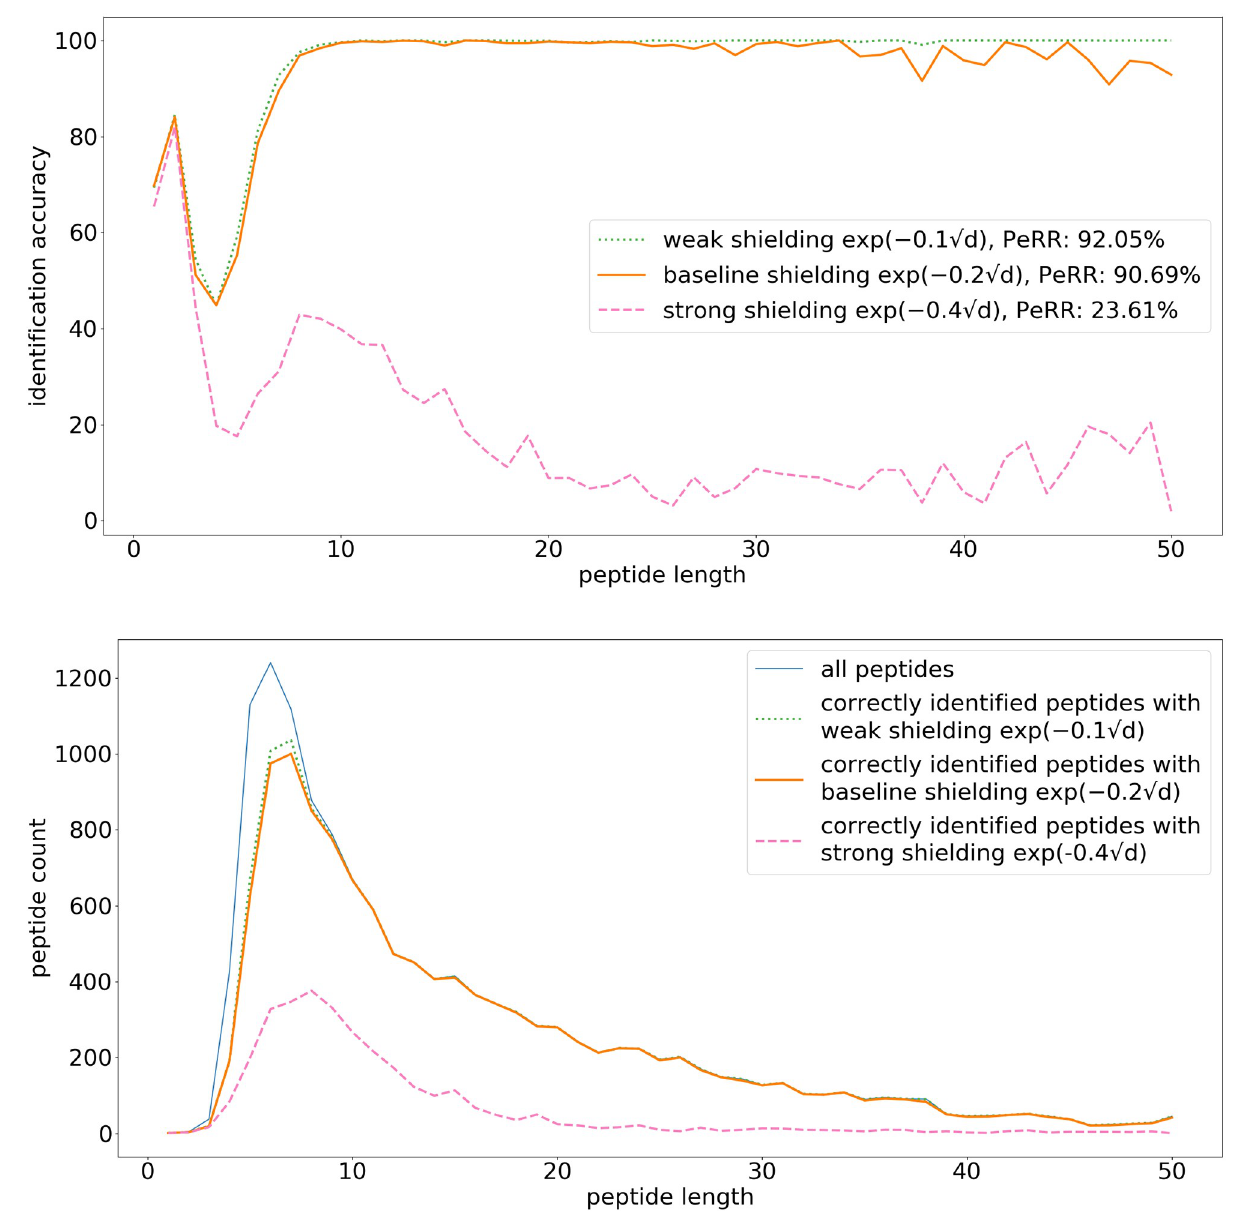
Fig 9. Peptide identification fraction: Shielding factor. (top) The fraction of correctly identified peptides for each peptide length. The legend additionally contains the peptidome recovery rate (PeRR). (bottom) The total peptide count for each peptide length, and the count of correctly identified peptides. The simulation uses the following parameters: 100 ms measurement time per amino acid, pH 2.5, initial SNR 10, and bound side chains. In this simulation the shielding factors are respectively exp ð(cid:0) 0 : 1 in the baseline Fig